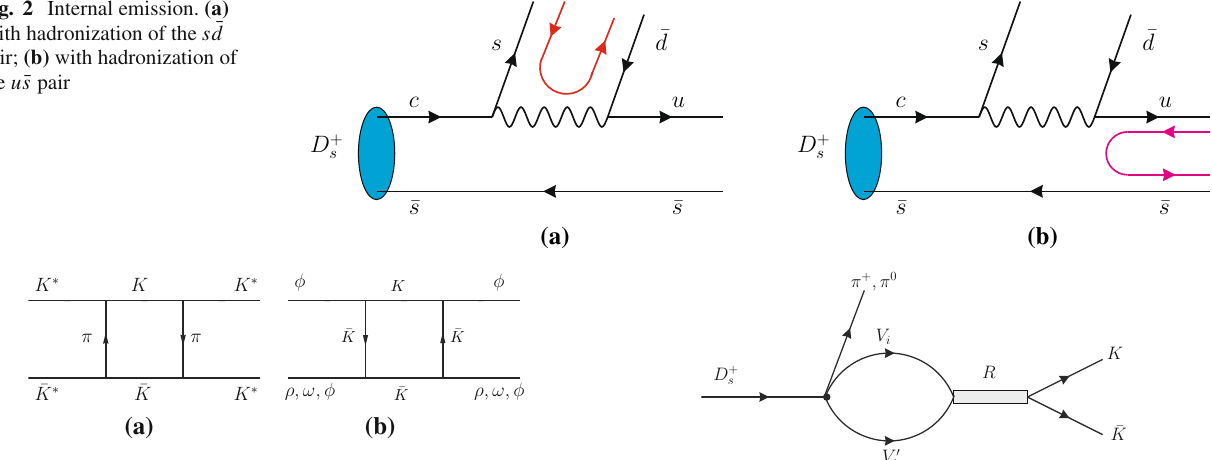
Fig. 3 Box diagrams considered in [5] to evaluate the width of the vector–vector molecular states